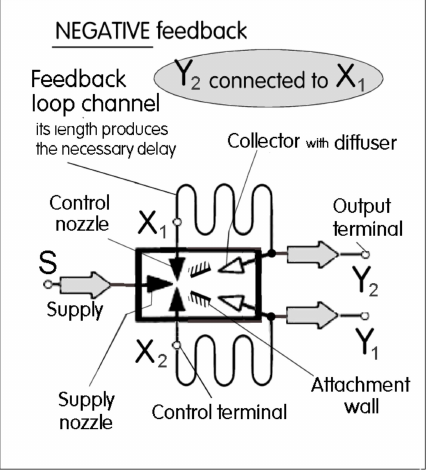
Figure 2. Schematic representation of the Warren’s [4] fluidic amplifier (black triangle: nozzle, white triangle: collector with output di ff user). The delays needed in the feedback loops, defining the pulse duration, are in this contemporary standard configuration produced by the flow progressing from Y to X. This paper introduces a di ff erent delay mechanism, with spin-up of captive